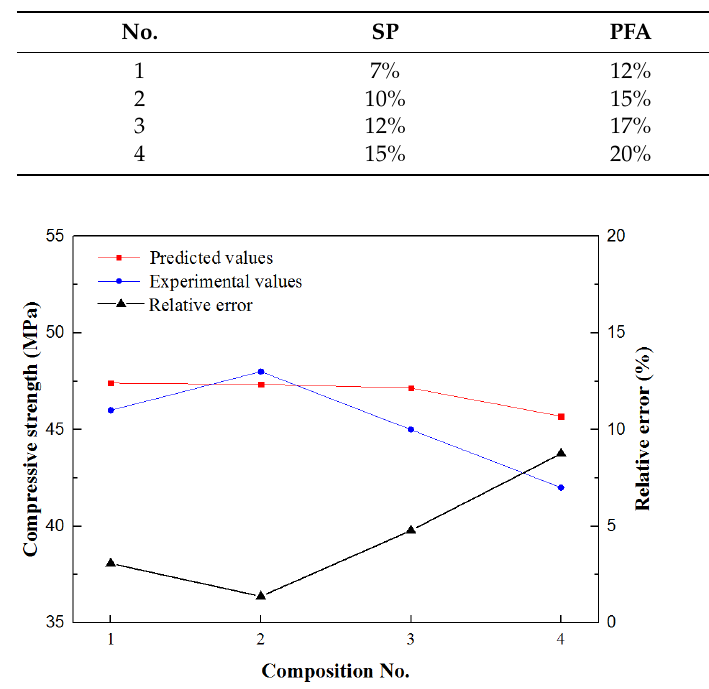
Figure 5. Compressive strength experiments, predicted values, and relative